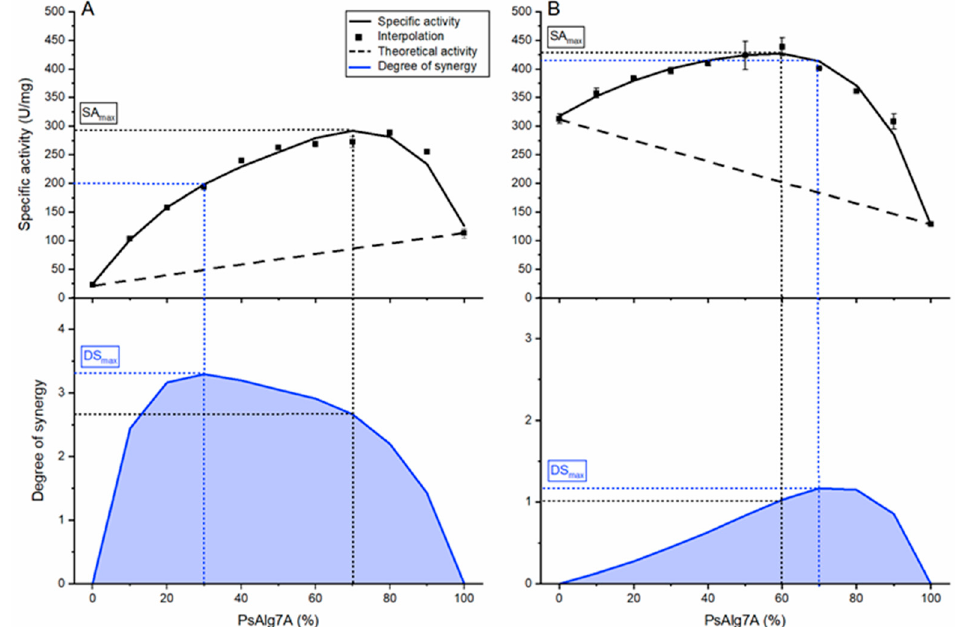
Figure 5. Endo-exo synergy experiment of PsAlg7A and PsMan8A. The total enzyme loads were at all points 0.2 µ M with varying ratios the two enzymes indicated by the % PsAlg7A on the x-axis which indicates the load of PsMan8A indirectly (% PsMan8A = 100%—% of PsAlg7A). The dashed line on the top panels represents the theoretical specific activities (SA) without the effect of synergy. The solid line through the specific activity data points in the top panels represents spline fits, which were used with the theoretical specific activity for calculating the curve in the bottom panels showing the degrees of synergy (DS). DS max = maximum degree of synergy. SA max = maximum specific activity. Error bars represent standard deviation from triplicate experiments: ( A ) Alginate (1.5 mg·mL − 1 ); ( B ) PolyM (1.5 mg·mL − 1 ).